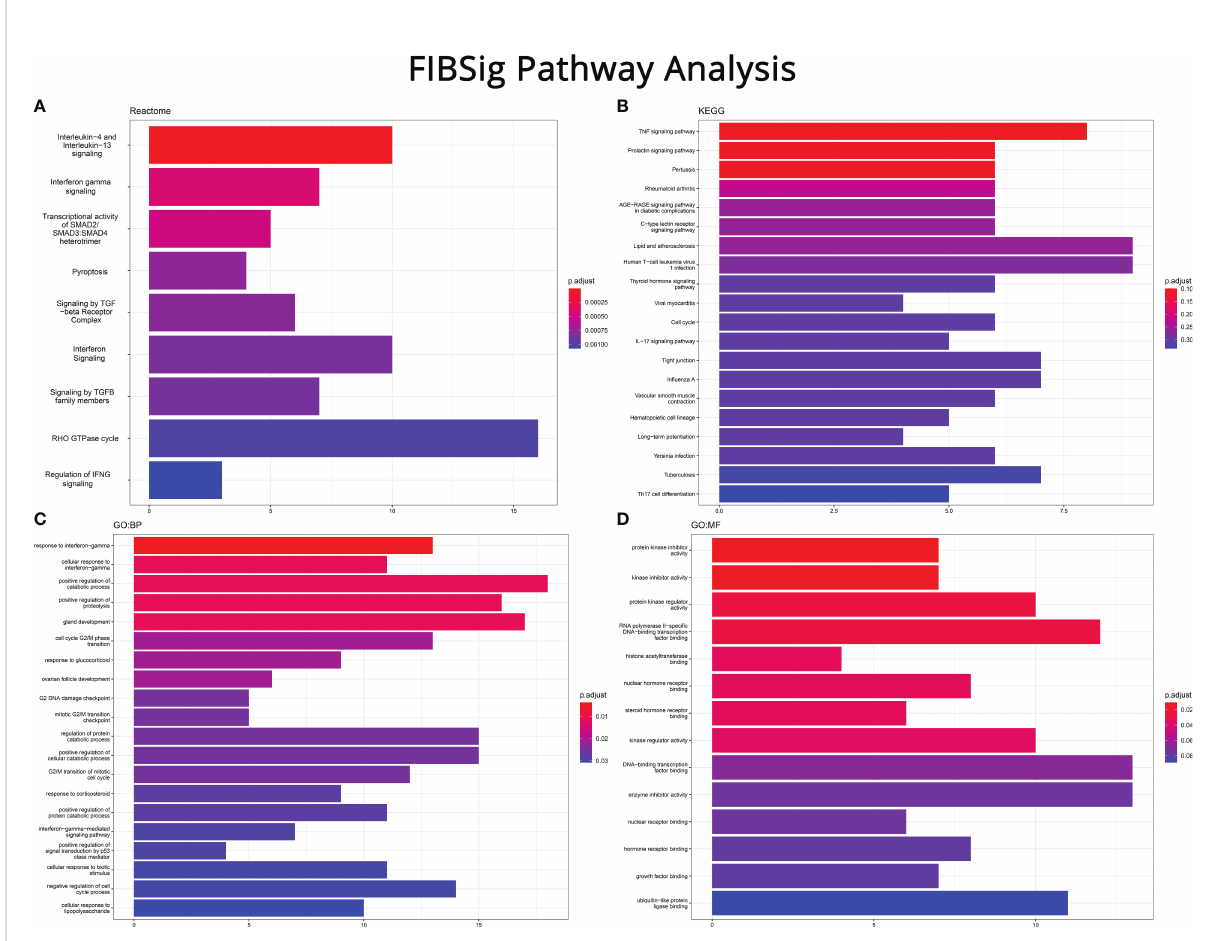
FIGURE 3 Pathway enrichment analysis on the FIBSig genes (performed with R and the clusterPro fi ler package) using (A) Reactome, (B) Kyoto Encyclopedia of Genes and Genomes (KEGG), (C) Gene Ontology: Biological Process (GO:BP) and (D) Gene Ontology: Molecular Function (GO: MF). Top to bottom: most to least FIBSIg genes as a ratio of the pathway ’ s total number of